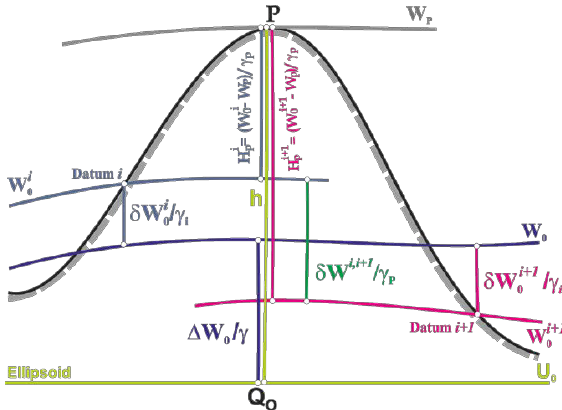
Figure 7. Vertical datum parameters by connected height